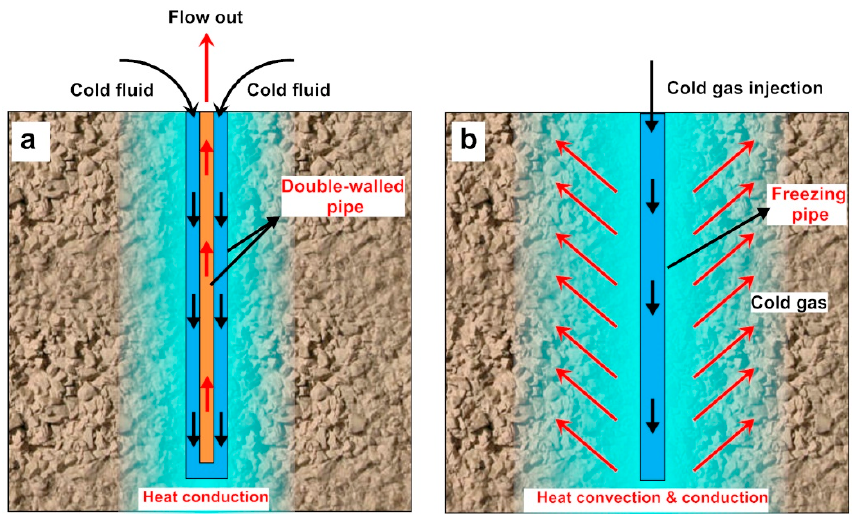
Figure 1. Schematic diagram of conventional artificial ground freezing (AGF) ( a ) compared to the proposed method ( b ), the blue area represents the frozen range.